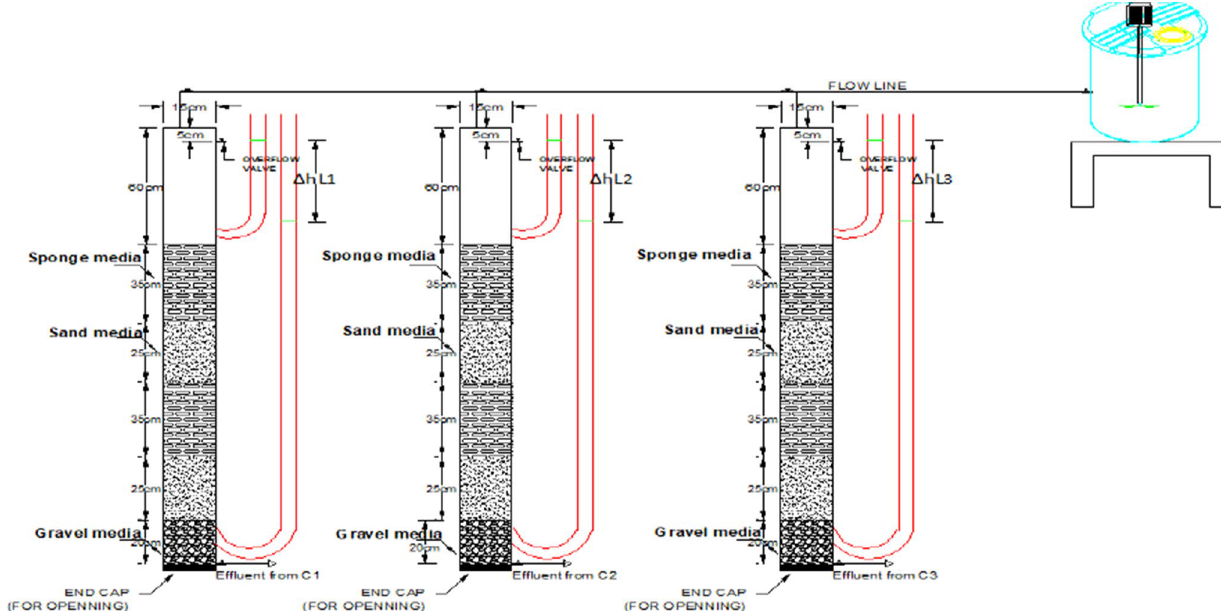
Fig. 12 The experimental setup for run (3) for optimum I.R and the head